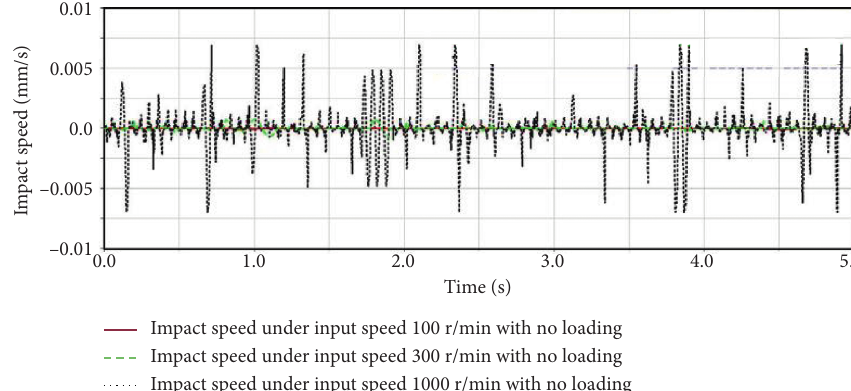
Figure 9: Impact speed of first-stage face gear pair with no